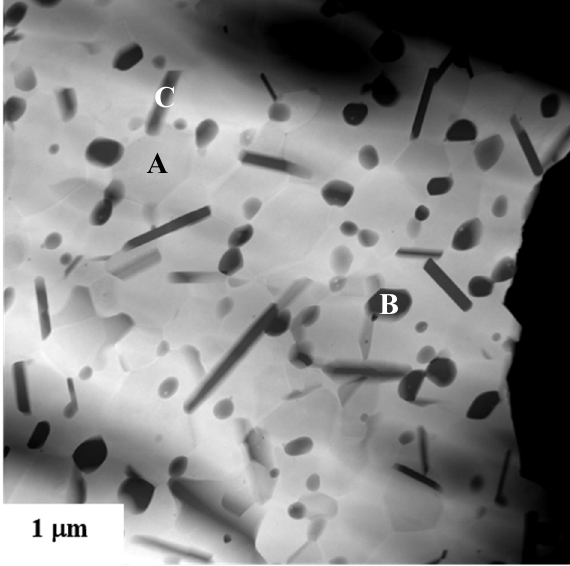
Figure 14. TEM micrograph of Zr 0.89 Ce 0.11 O 2 /Al 2 O 3 /SrAl 12 O 19 composite, produced by the surface modification method. Letters A, B and C denote the Ceria-stabilized ZrO 2 , the α -Al 2 O 3 and the SrAl 12 O 19 phases, respectively, as determined by EDX